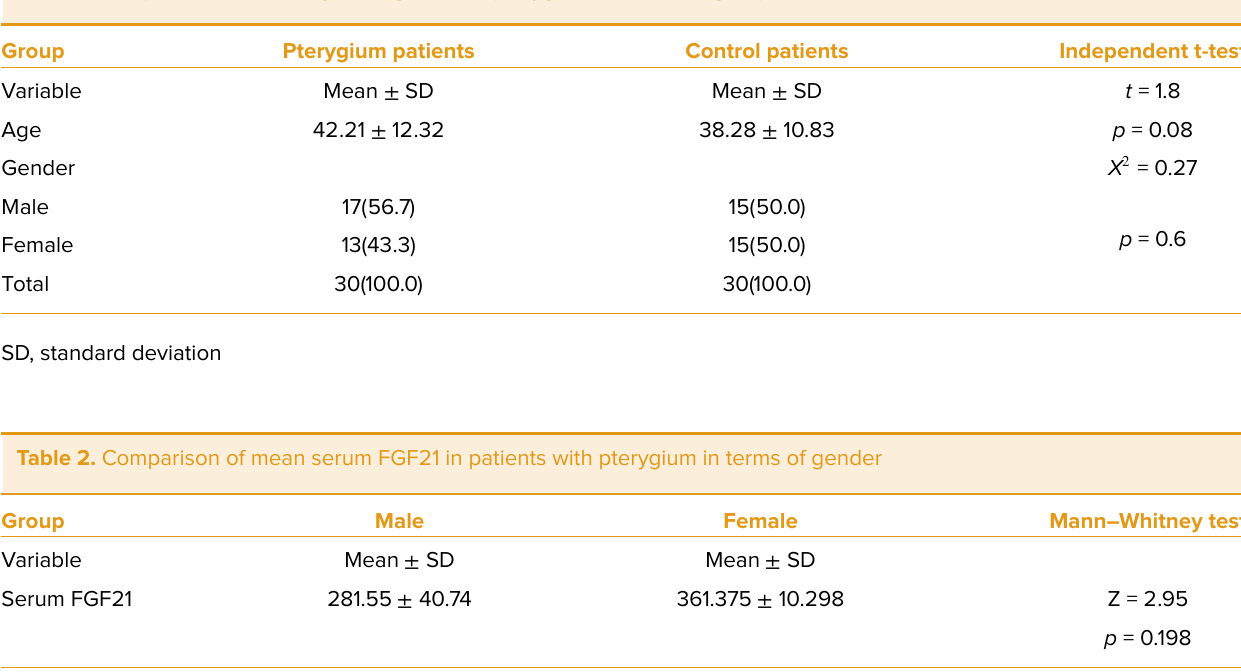
Table 1. Comparison of mean age and gender in pterygium and control groups